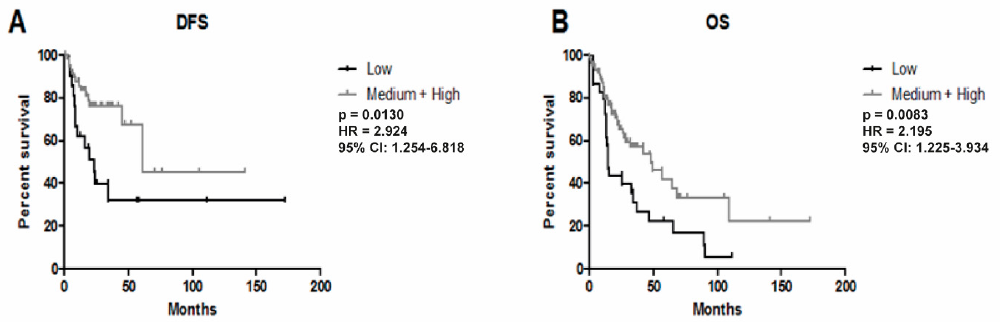
Figure 6. Influence of YRNA1 expression on HNSCC patients’ outcome. ( A ) Disease-free survival (DFS) and ( B ) overall survival (OS); p < 0.05 was considered to be significant. CI, confidence interval; HR, hazard ratio.